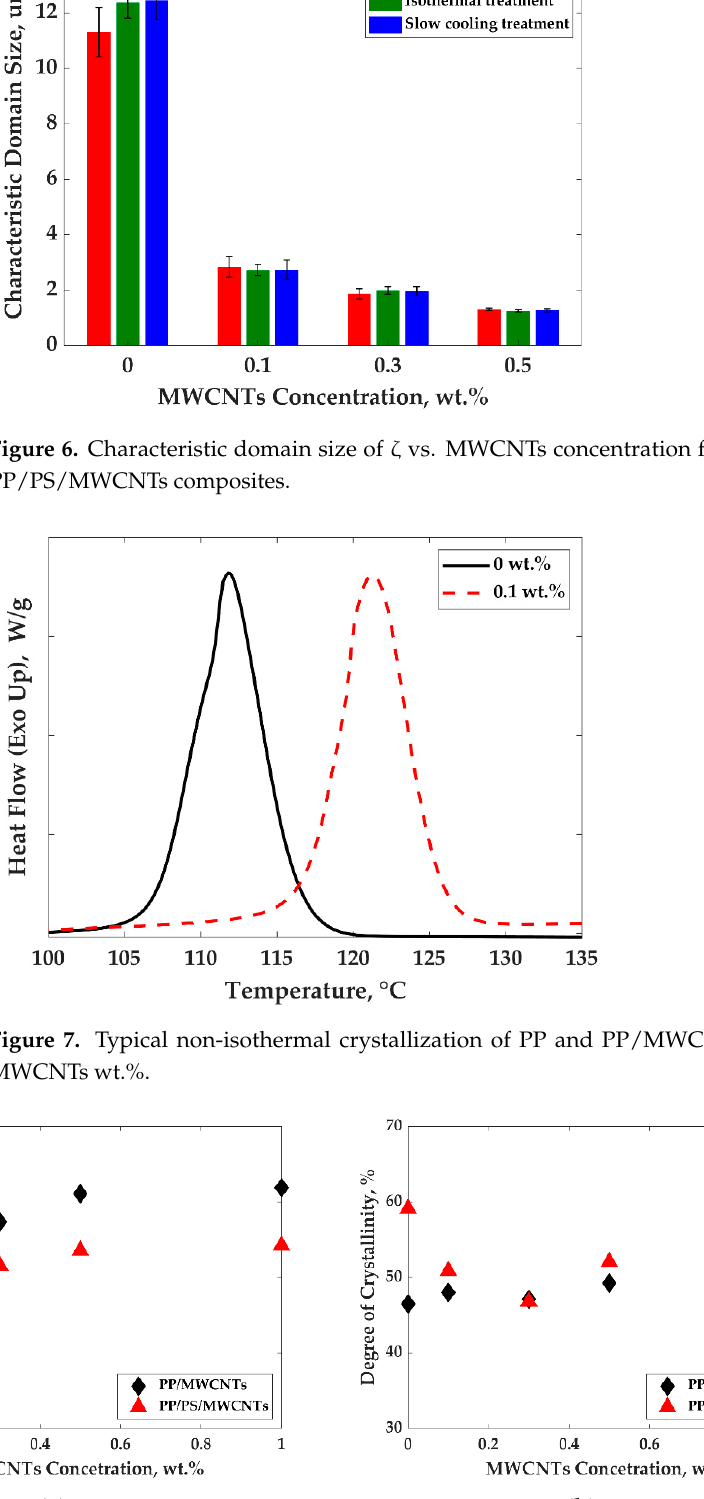
Figure 6. Characteristic domain size of ζ vs. MWCNTs concentration for different treatments for PP/PS/MWCNTs composites.